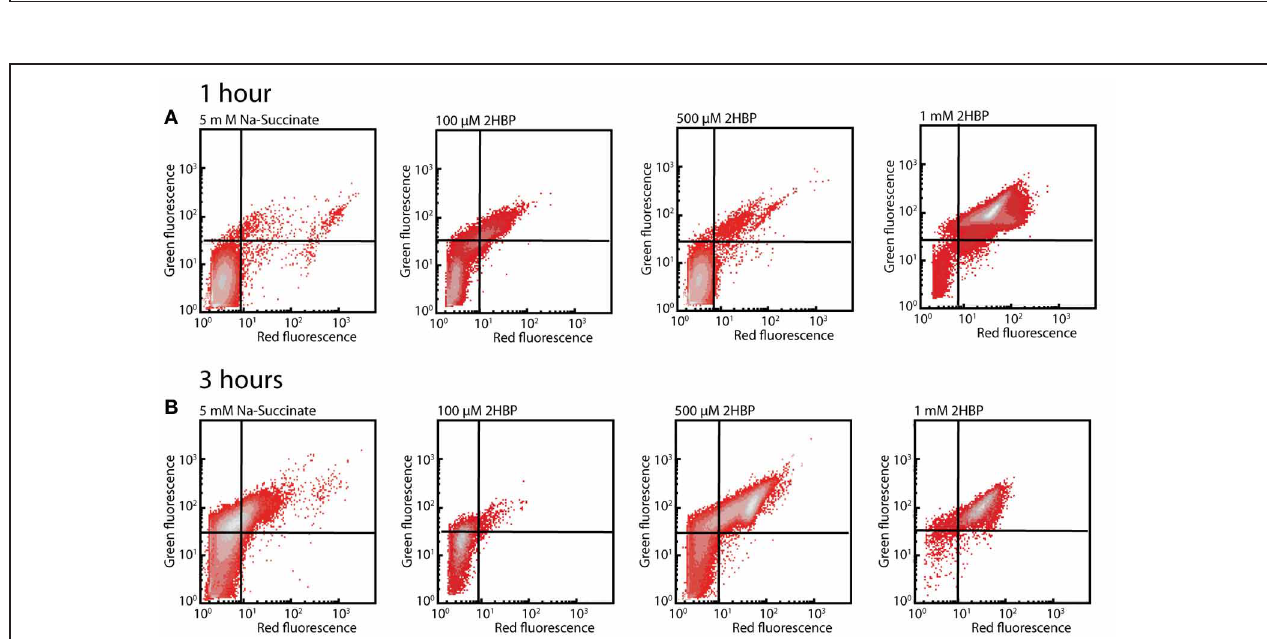
1mM concentrations. Cells sampled after 1h exposure and stained with SYTO9 plus EB. (B) As for (A) , but sampled and stained after 3h exposure.